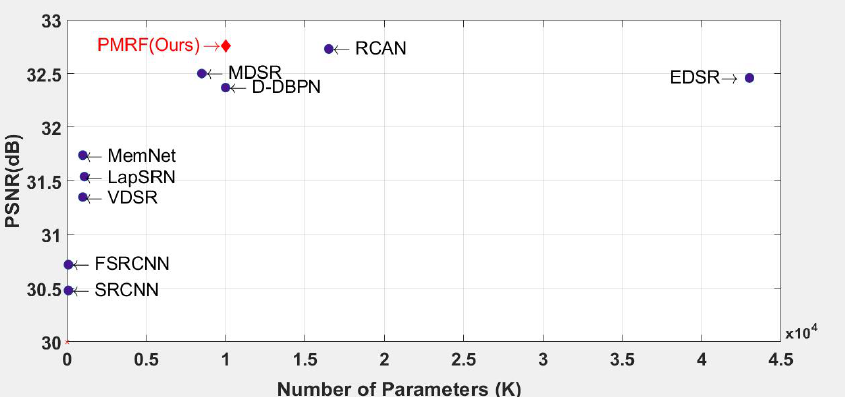
Figure 20. Performance and number of parameters evaluated on the Set5 dataset at × 4 scale.